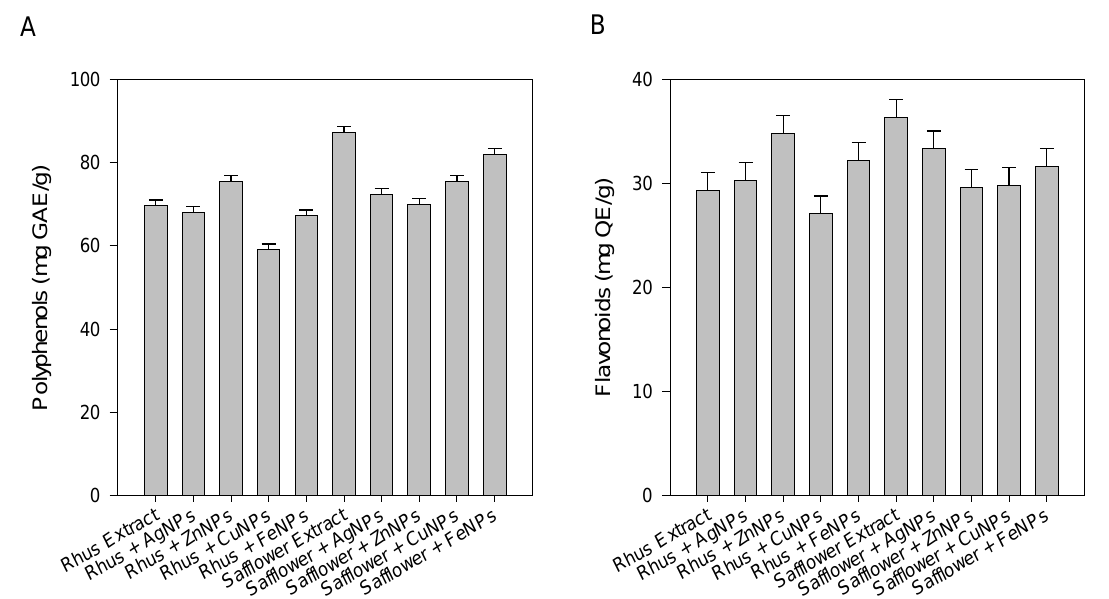
Figure 4. ( A ) Total polyphenolics (mg GAE g −1 ) and ( B ) total flavonoids (mg QE g −1 ) of rhus and safflower extracts and their nanoparticles.